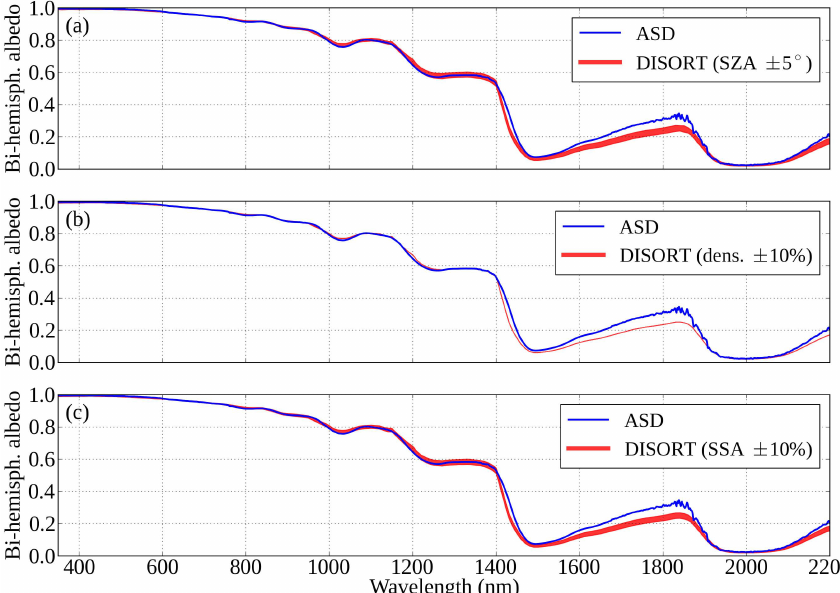
Fig. 14. Measured and simulated albedo at Summit, on 20 June 2011. (a) Impact of a variation of ± 5 ◦ in SZA. (b) Impact of a variation of ± 10% in density. (c) Impact of a variation of ± 10% in